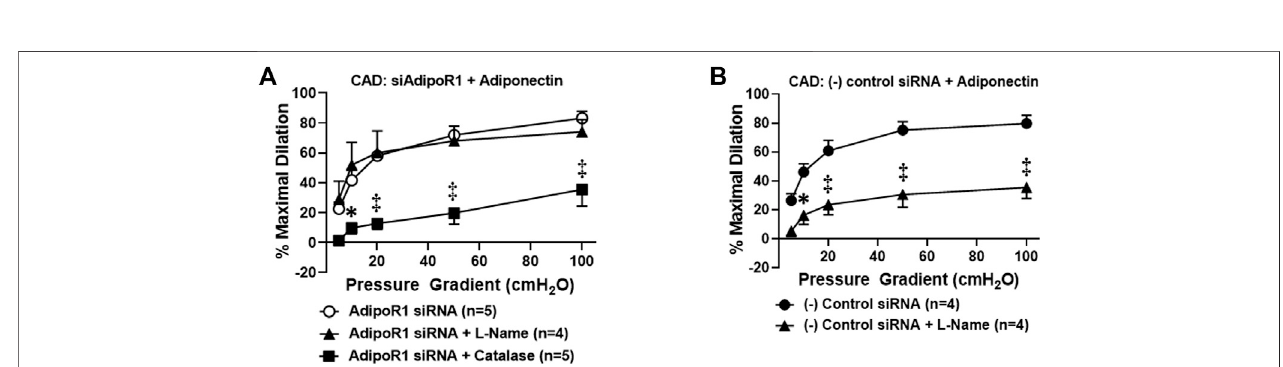
FIGURE 2 | Adiponectin restores NO-dependent FID via activation of AdipoR1 in CAD microvessels. (A) FID is signi fi cantly decreased in arterioles collected from patients with CAD treated with both siAdipoR1 and adiponectin in the presence of PEG-catalase ( n = 5) compared to vessels treated with siAdipoR1 alone ( n = 5) whereas L-Name had no effect ( n = 4). (B) Intraluminal treatment with negative control siRNA does not impair adiponectin-induced restoration of NO as the mediator of FID asdilation isinhibited in thepresence ofL-NAME ( n =4) compared tonegative control siRNA alone ( n =5). ‡ p < 0.01, * p < 0.05versusAdipoR1 siRNA alone. n indicates the number of